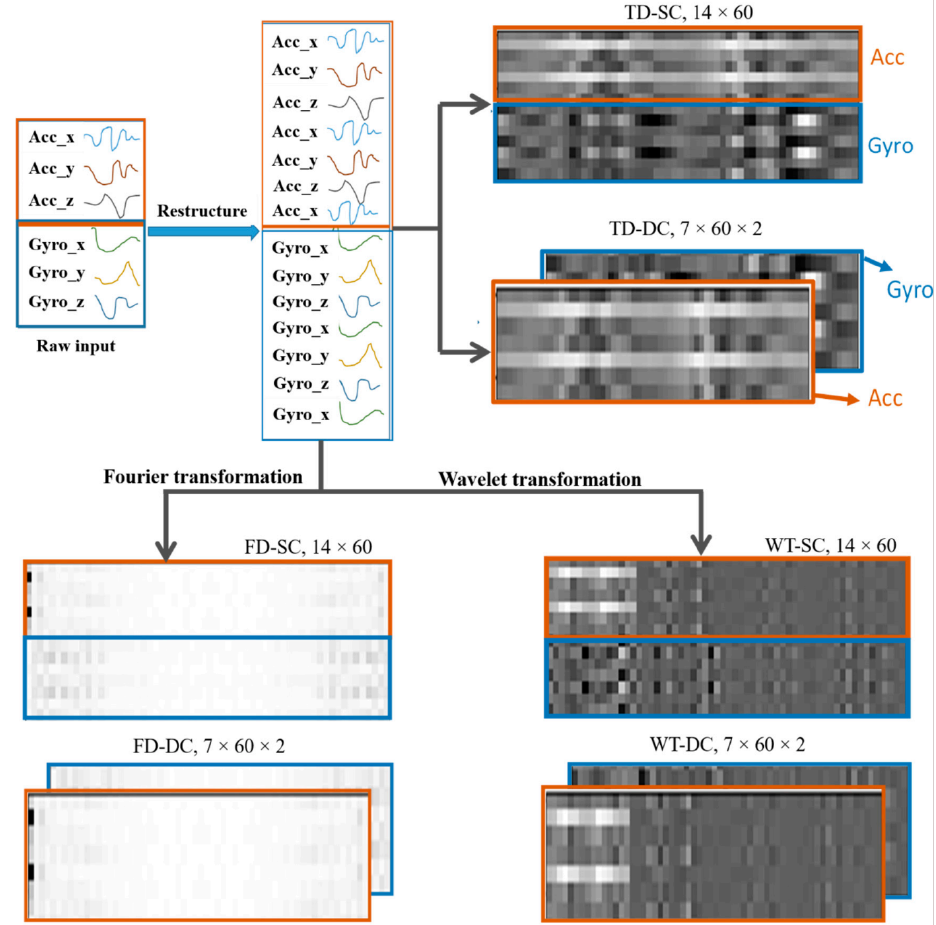
Figure 8. Virtual images of input data representations. TD-SC (time-domain-single channel), TD-DC (time-domain-double channel), FD-SC (frequency domain-single channel), FD-DC (frequency domain- double channel), WT-SC (wavelet transformation-single channel), WT-DC (wavelet transformation- double